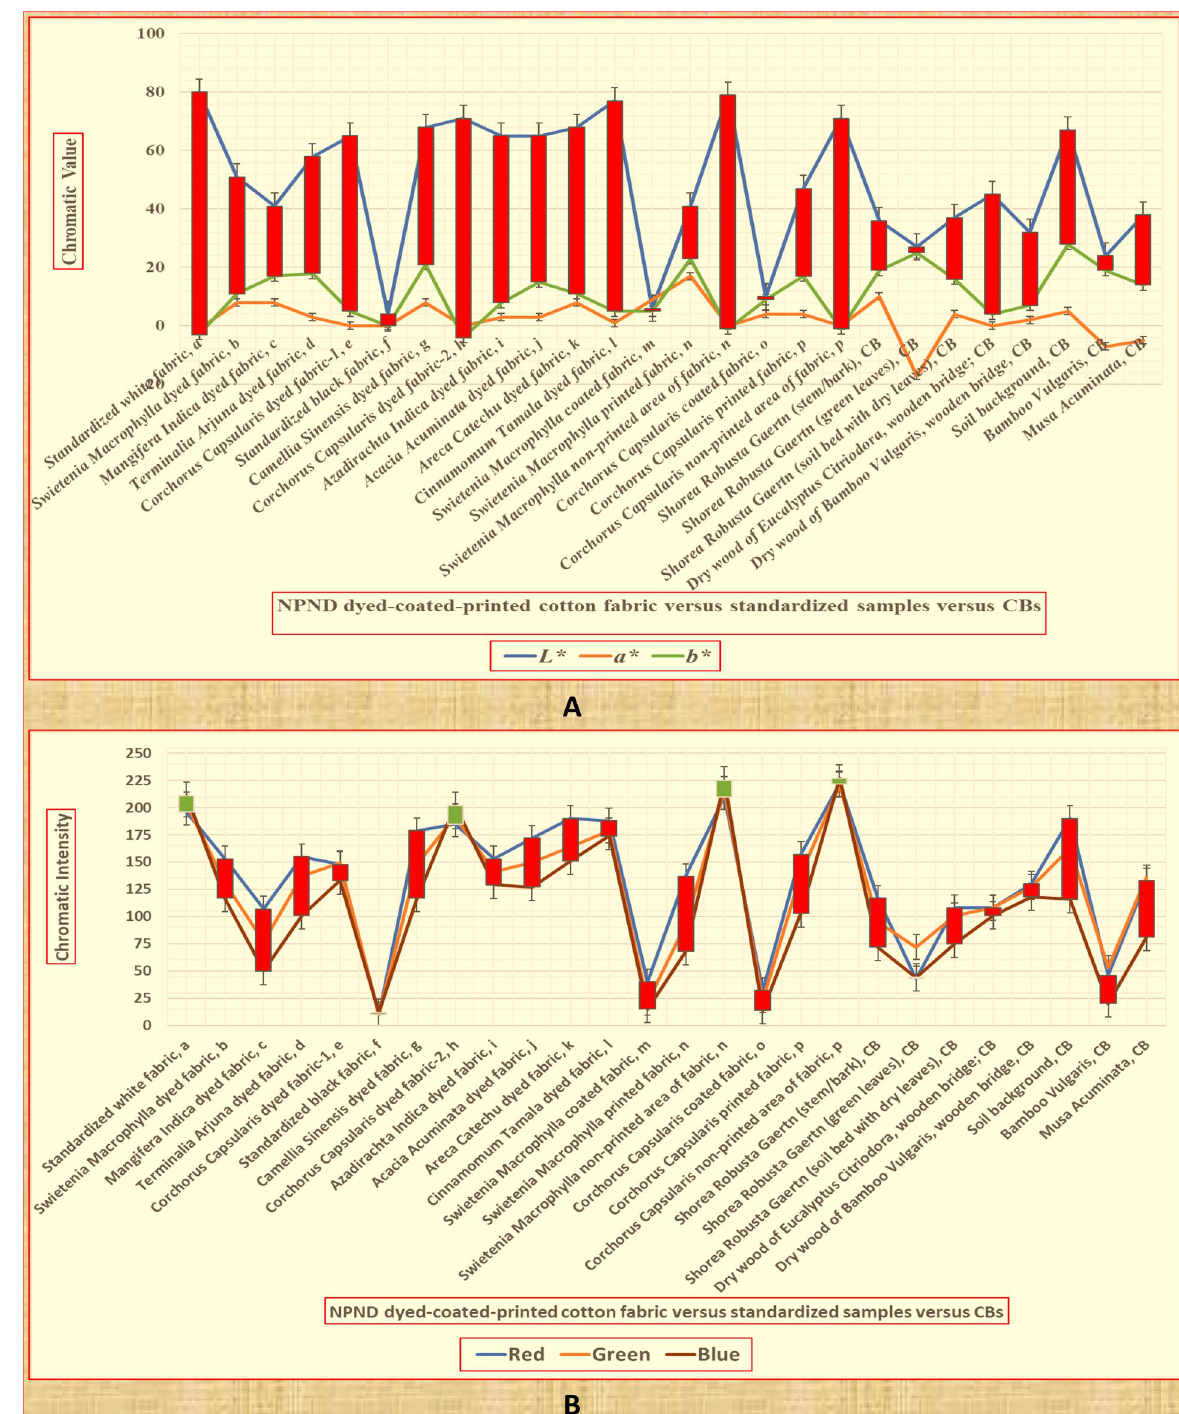
Figure 12. Quantitative comparison of CIE L*, a*, b* ( A ) and RGB ( B ) values for NPND dyed-coated-printed part placed against multidimensional